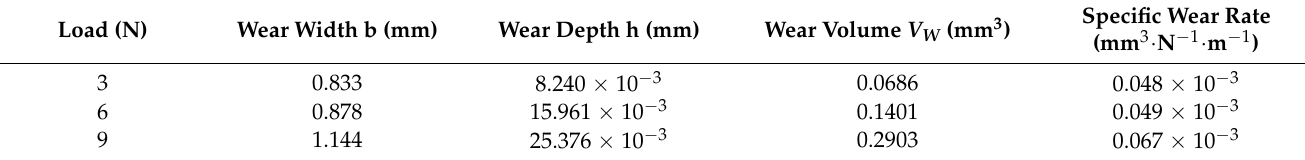
Table 4. The wear width, depth, volume, and specific wear rate of alloying coating under different load. Load